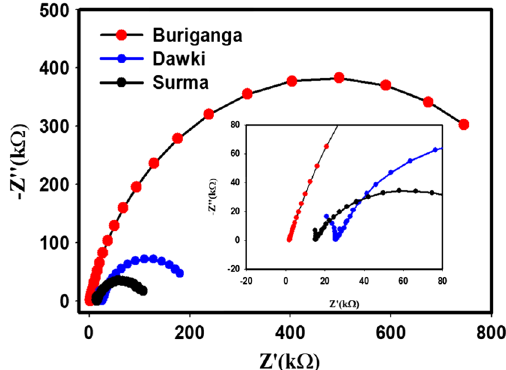
Fig. 2 EIS spectra of different river waters recorded using a Pt disk